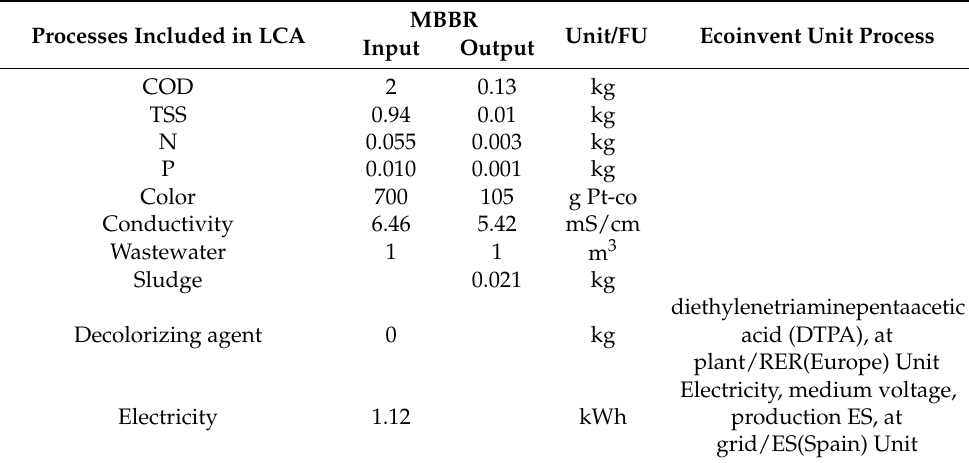
Table 9. Inventory analysis of the MBBR-MBR treatment.